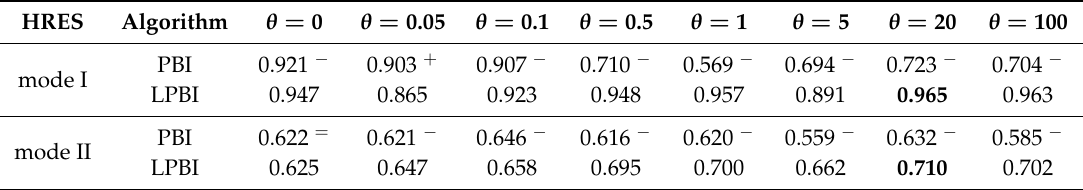
Table 3. The mean hypervolume (HV) results of MOEA/D-LPBI and the original version with different θ for HRES. The symbol “+”, “ − ” or “=” means that the counterpart is statistically better than, worse than or comparable to MOEA/D-LPBI. The best HV value for each problem is marked in boldface .